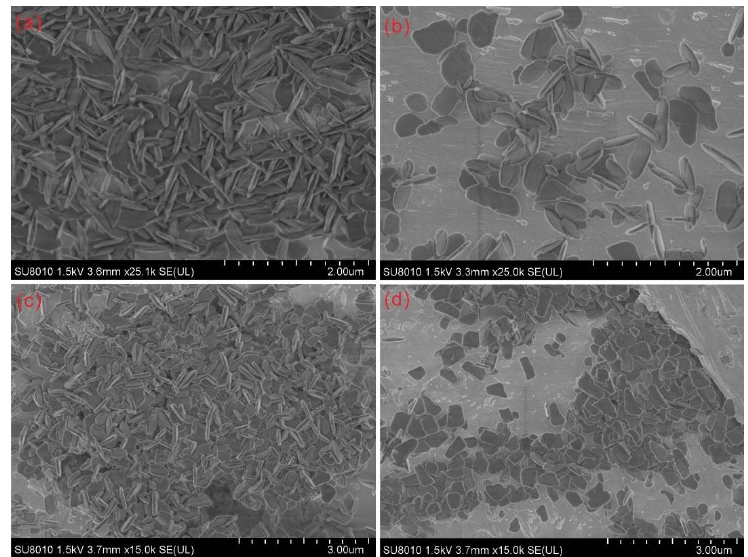
Figure 5. Representative SEM micrographs of zirconia micro-nanoflakes synthesized by 0.01 mol/L of the initial solution concentration: ( a ) No. 2 at 250 °C, 80 MPa, and 14 h; ( b ) No. 6 at 400 °C, 80 MPa, and 12 h; and ( c , d ) No. 7 at 500 °C, 80 MPa, and 12 h.